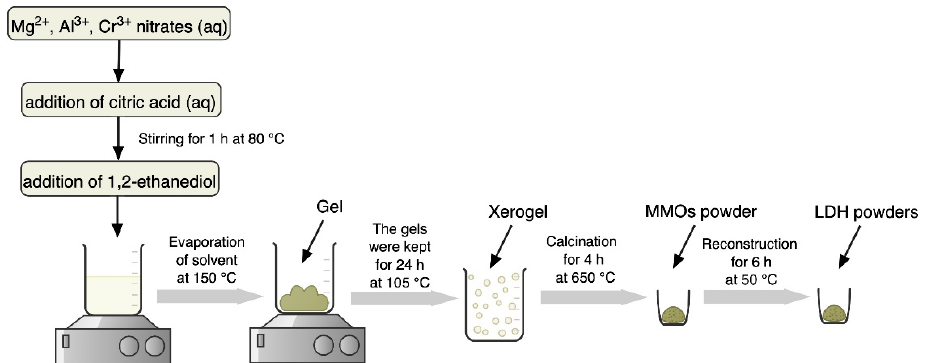
Figure 5. Schematic diagram of the sol-gel preparation of Mg 3 Al 1-x Cr x layered double hydroxides (LDHs). ides